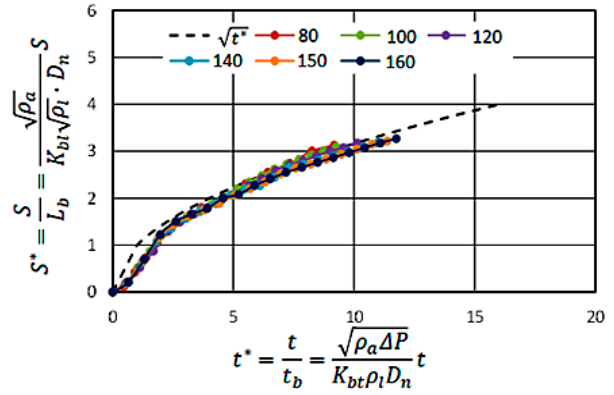
Figure 19. Normalized diesel spray penetration, D n = 0.260 mm, ρ a = 12 kg/m 3 (at 1.0 MPa).